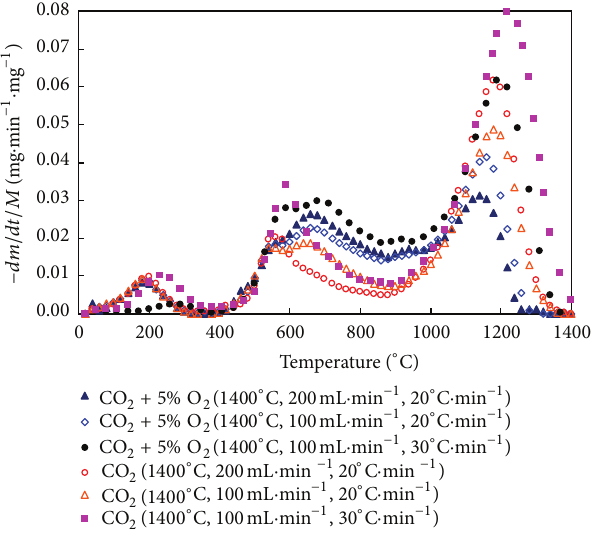
Figure 17: Coal conversion rate versus atmospheric temperature. Figure 18: Heat generation rate versus atmospheric